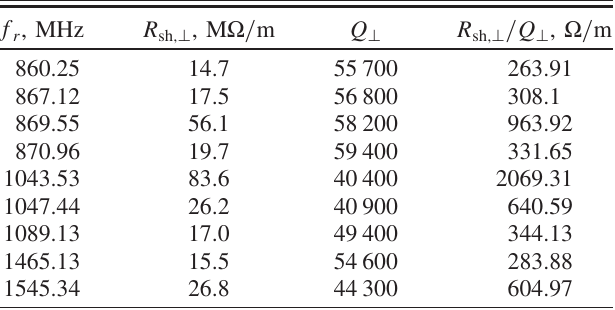
TABLE II. Transverse HOMs of the seven-cell PETRA-III rf